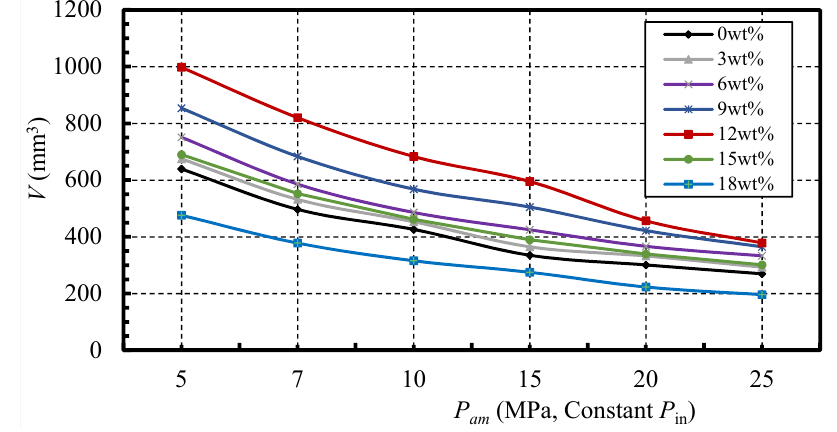
Figure 8. Rock erosion characteristics under various ambient pressures and a constant inlet pressure.